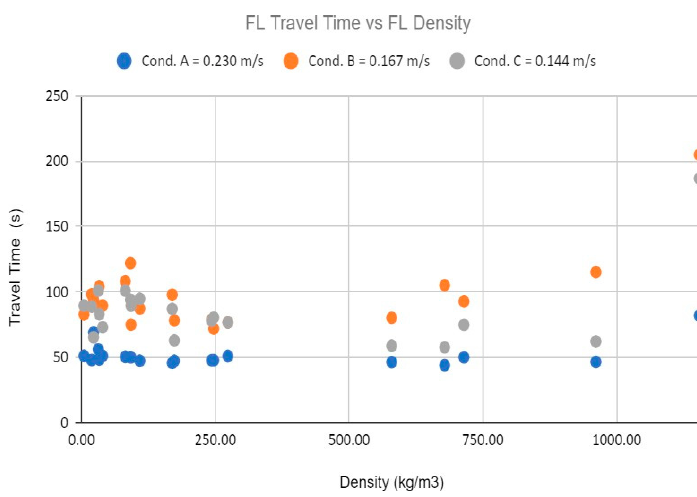
Figure 8. FL travel time vs. FL density in all conditions.